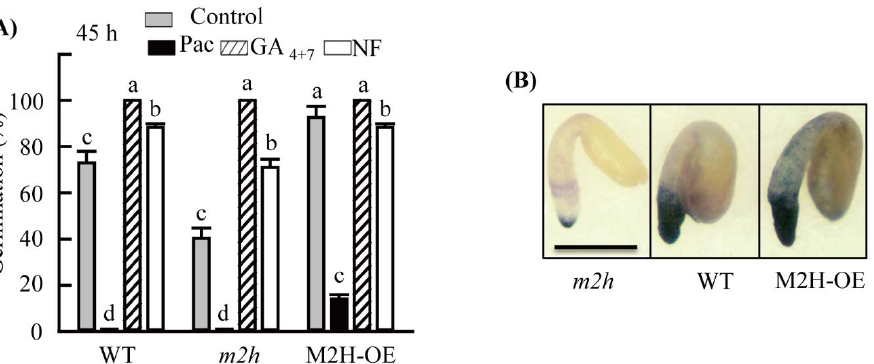
Figure 6. Effects of gibberellic acid (GA), GA inhibitor (paclobutrazol), and abscisic acid (ABA) in- hibitor (norflurazon) on seed germination in various A . thaliana lines. ( A ) Percentage of germination